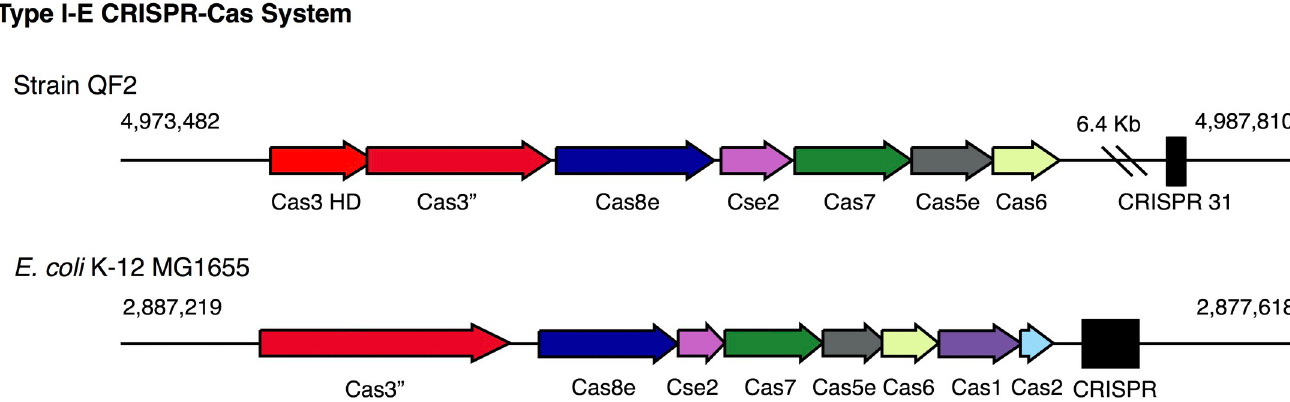
Fig 8. Class I, Type I-E CRISPR-Cas system encoded in the WGS of strain QF2. ( top ) The Type I-E CRISPR-Cas operon encoded by strain QG is located from 4,973,482 to 4,987,810 and includes seven genes. The Type I-E cascade is followed by CRISPR 31, consisting of two repeats and a single spacer. ( bottom ) The canonical Type I-E CRISPR-Cas system encoded in the genome of E . coli K-12 MG1655 is located from 2,887,219 to 2,877,618 and includes eight genes. The Type I-E cascade is followed by a CRISPR 31, consisting of five repeats and four spacers.